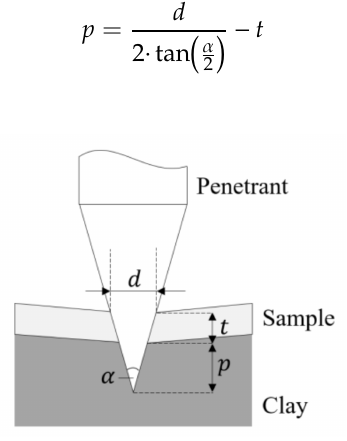
Figure 3. Calculation of the penetration depth p